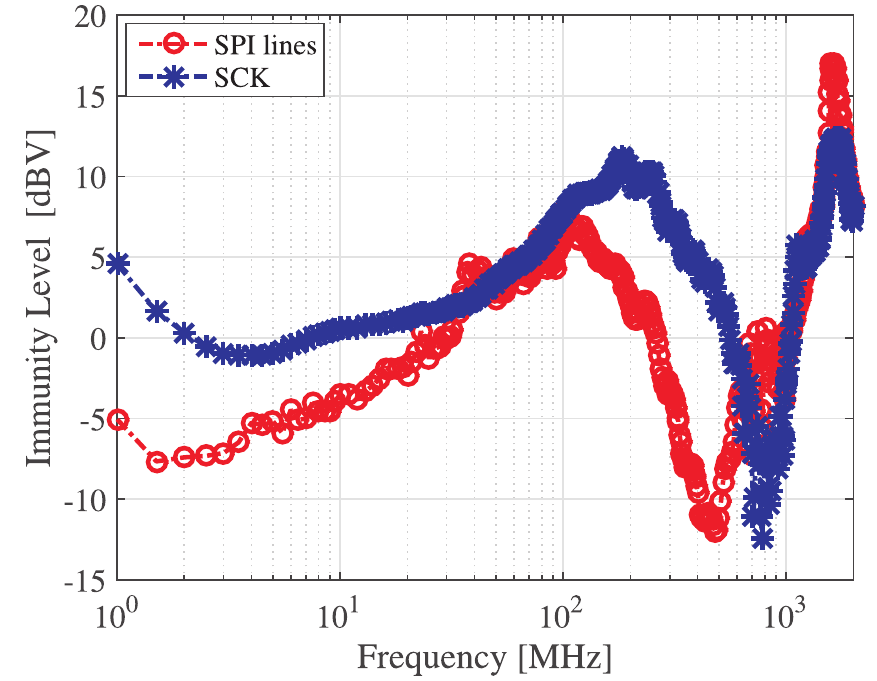
Figure 10. Total RF voltage induced at the SPI input pins: simultaneous injection on the four SPI lines and injection on the single SCLK